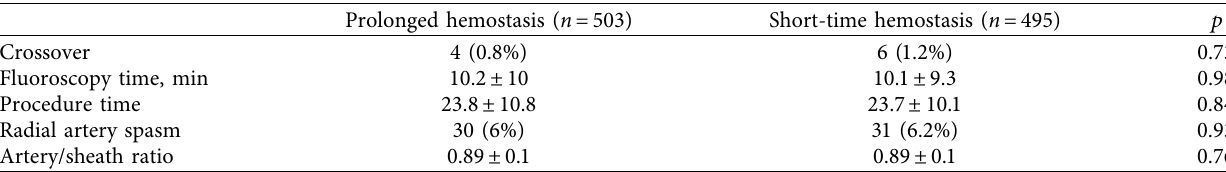
Table 2: Periprocedural characteristics.